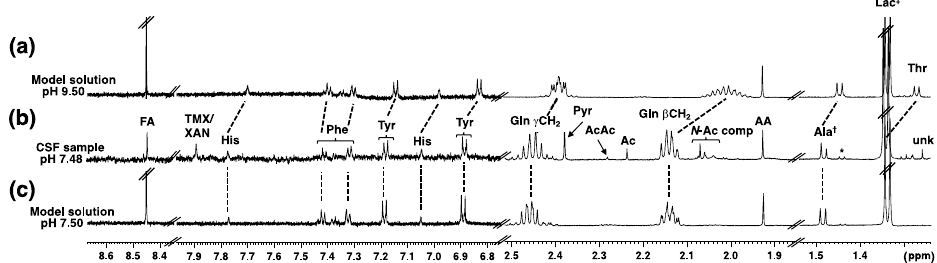
Figure 1. Partial one-dimensional 1 H NMR spectra of the model solution ( a, c ) and an